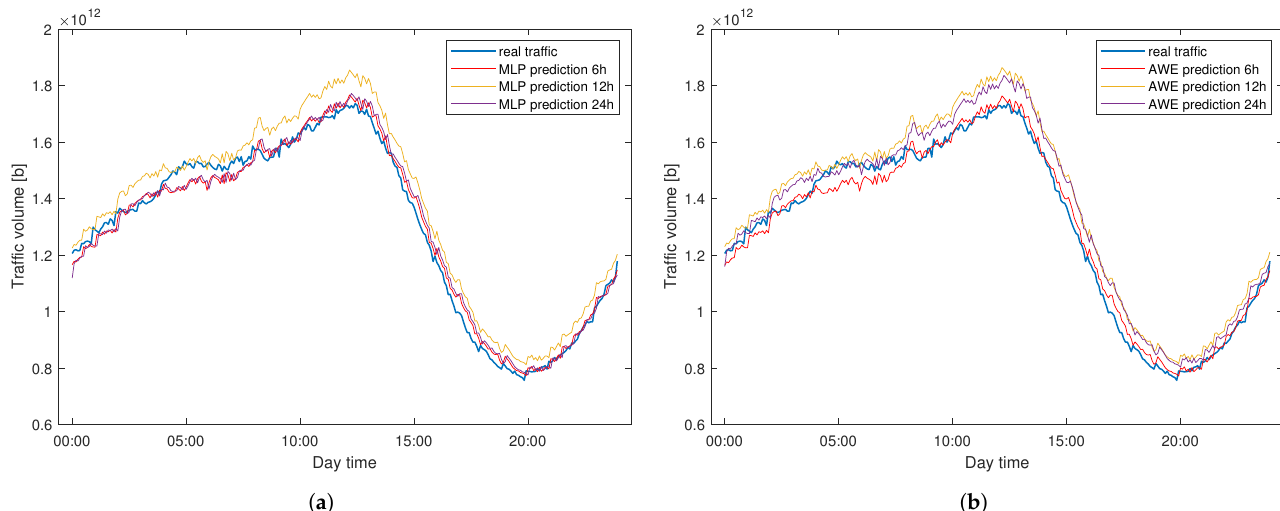
Figure 14. Efficiency of machine learning-based traffic prediction—observed and predicted traffic as a time function for SIX and 4 January 2021. ( a ) MLP method, ( b ) AWE method.